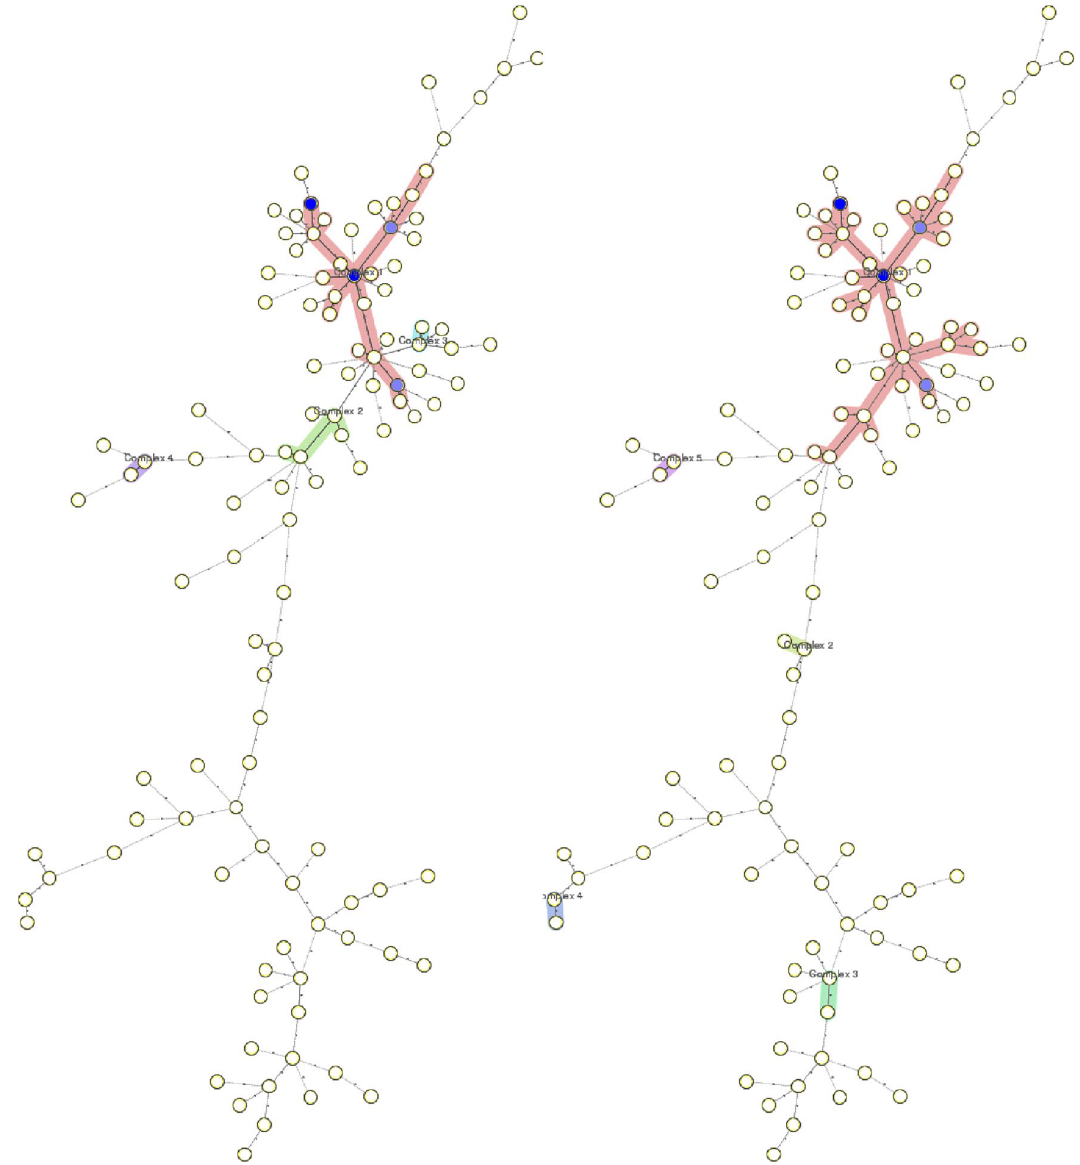
Figure 2. Minimum spanning tree (MST) based on 24-locus MIRU-VNTR demonstrating lineage classification of the 120 Mycobacterium tuberculosis isolates. ( A ): MST based on SLV (Single Locus Variation), ( B ): MST based on DLV (Double Locus